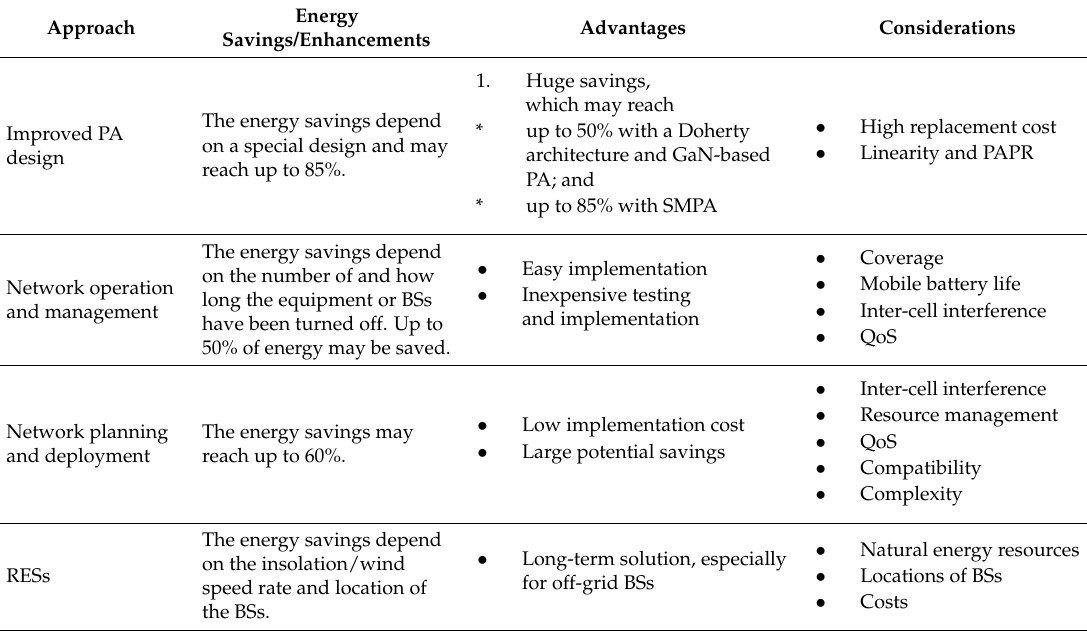
Table 6. Brief comparison of the approaches presented in this